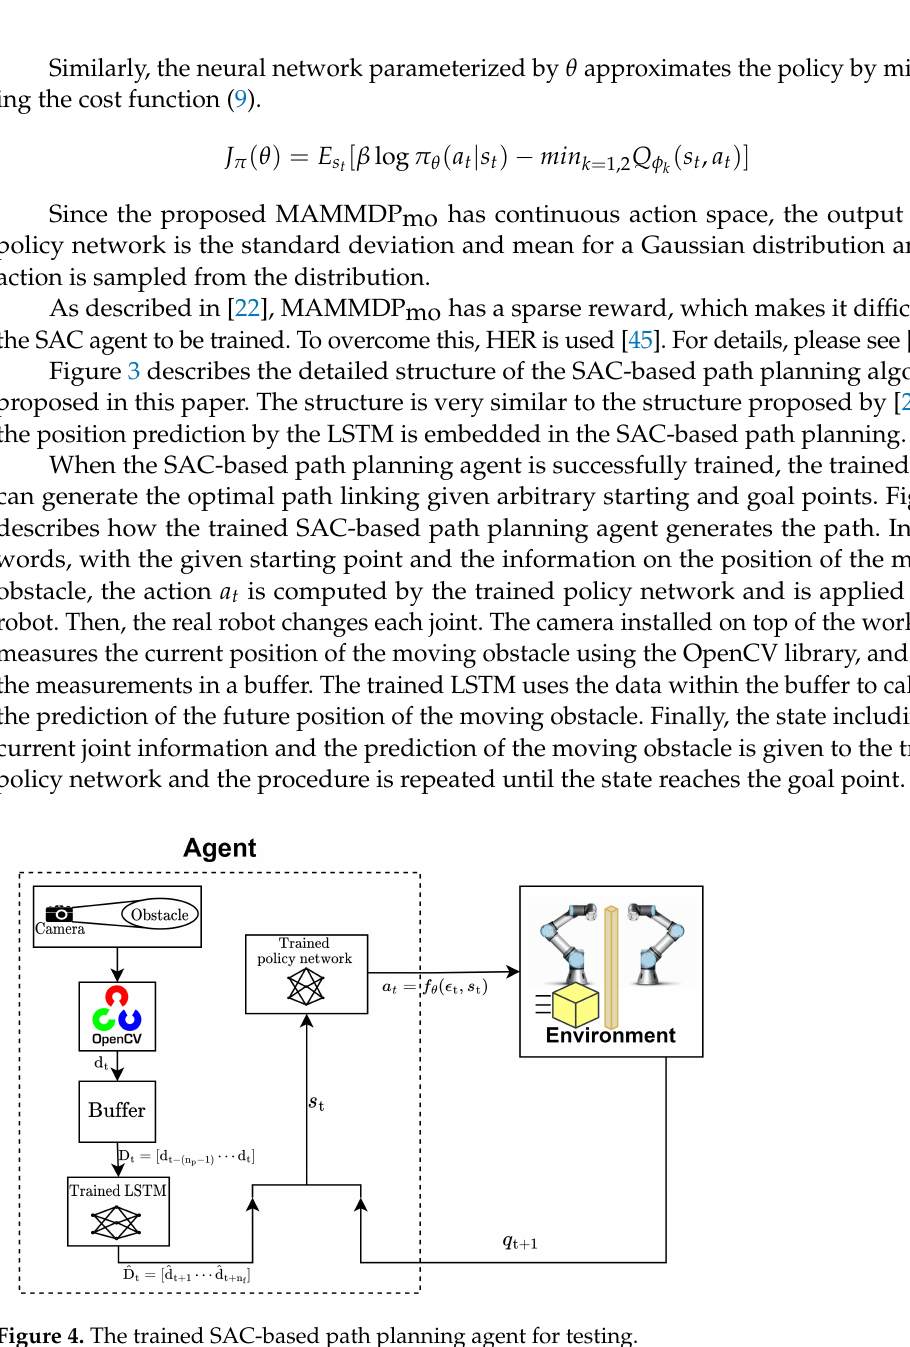
Figure 4. The trained SAC-based path planning agent for testing. Algorithm 1 at the end of the paper summarizes the proposed SAC-based path plan- ning with the